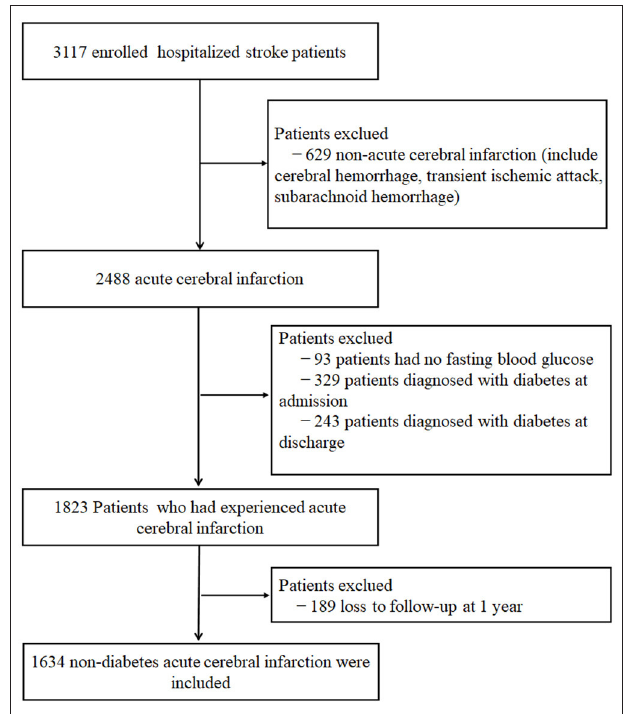
FIGURE 1 | Flow chart of the screening and enrollment of study